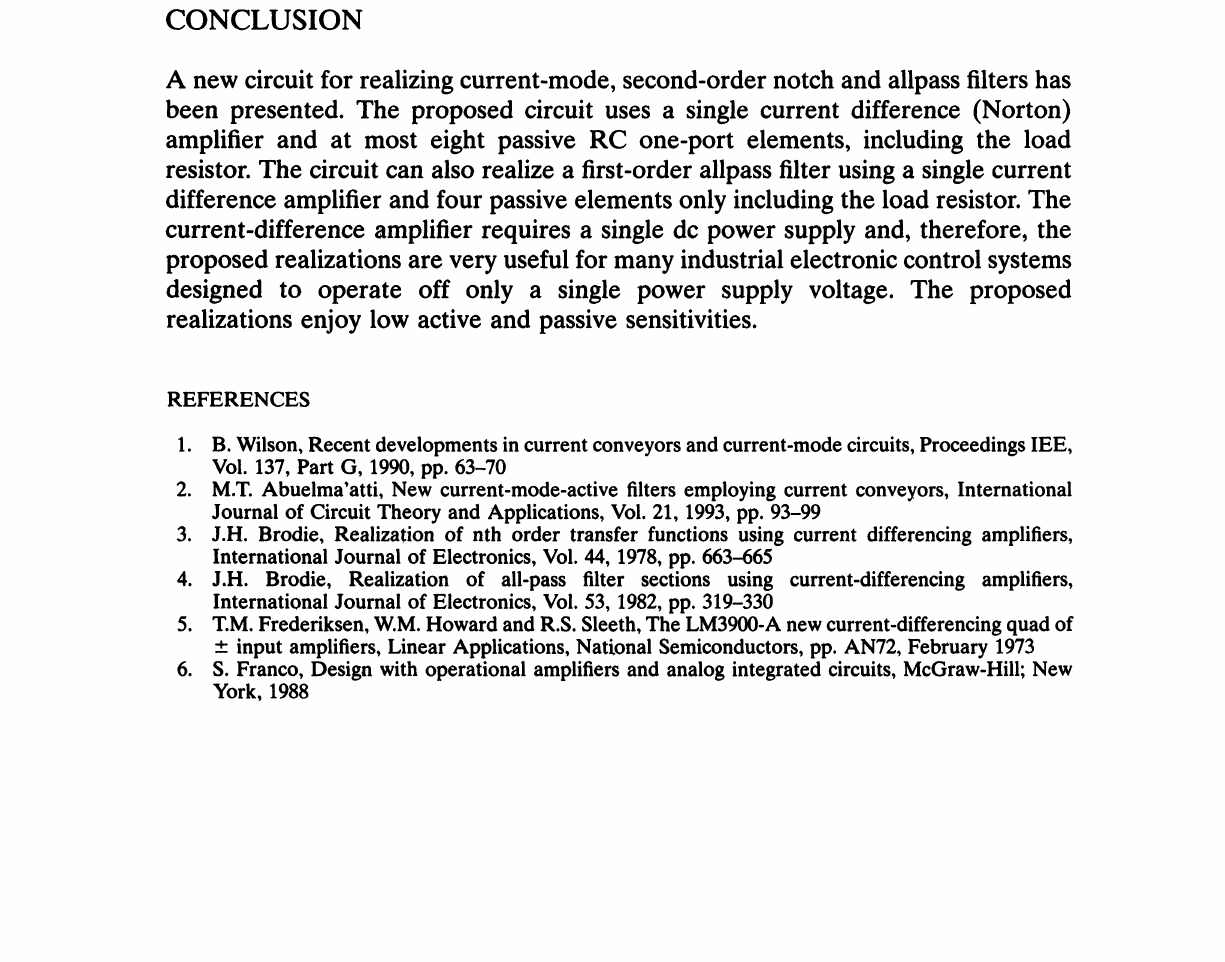
FIGURE 3 Measured notch filter characteristic using